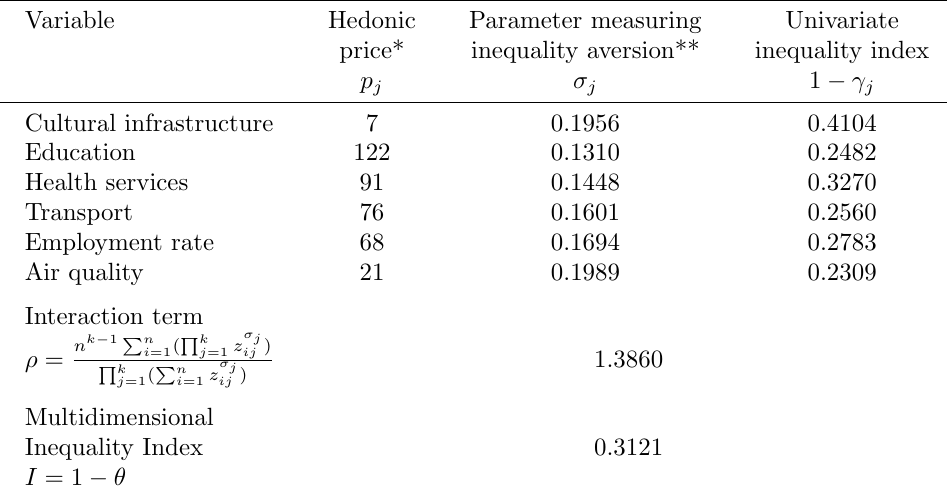
Table 2: Amenity hedonic prices and multidimensional inequality index decomposed in the six unidimensional inequality indices plus an interaction